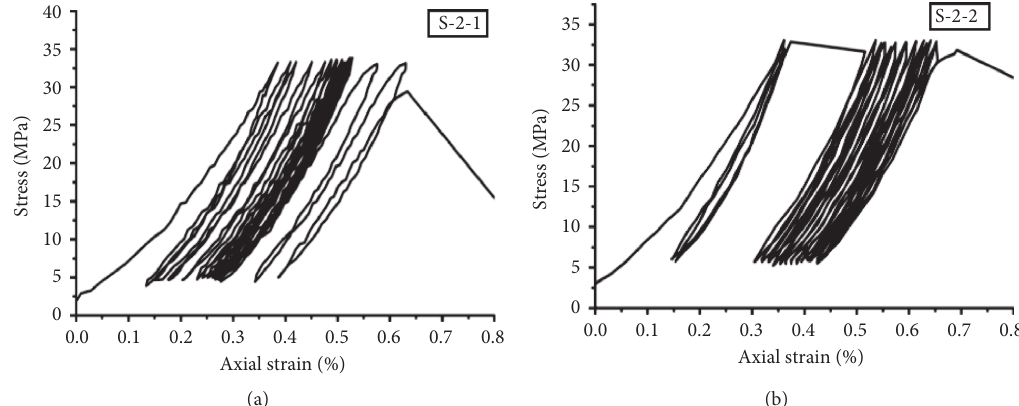
Figure 13: The stress-strain curves of S-2 rock sample group under cyclic loading and unloading (5–33.5MPa). (a) S-2-1 sample. (b) S-2-2 sample.